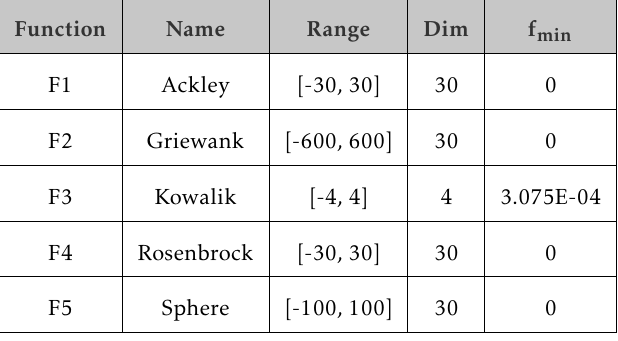
Table 1. Benchmark functions